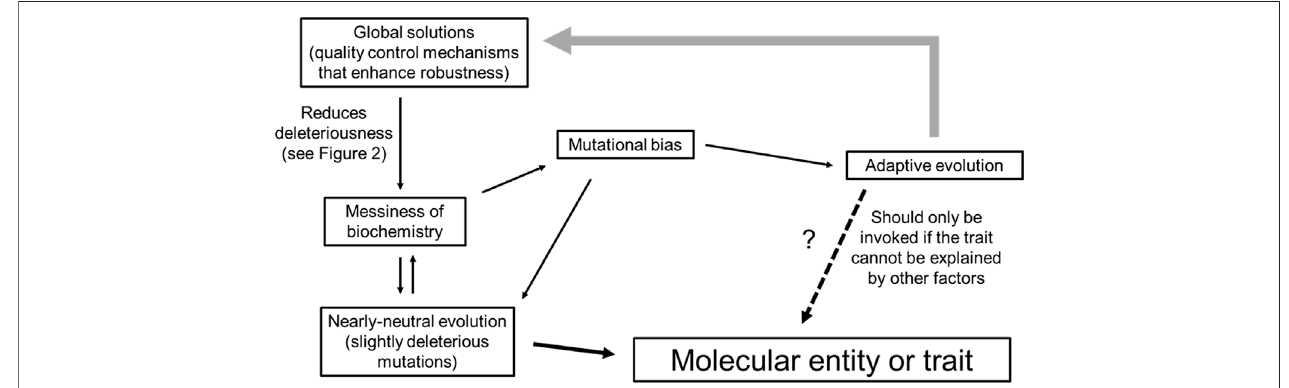
FIGURE 1 | The mechanisms that shape traits in a weak selection